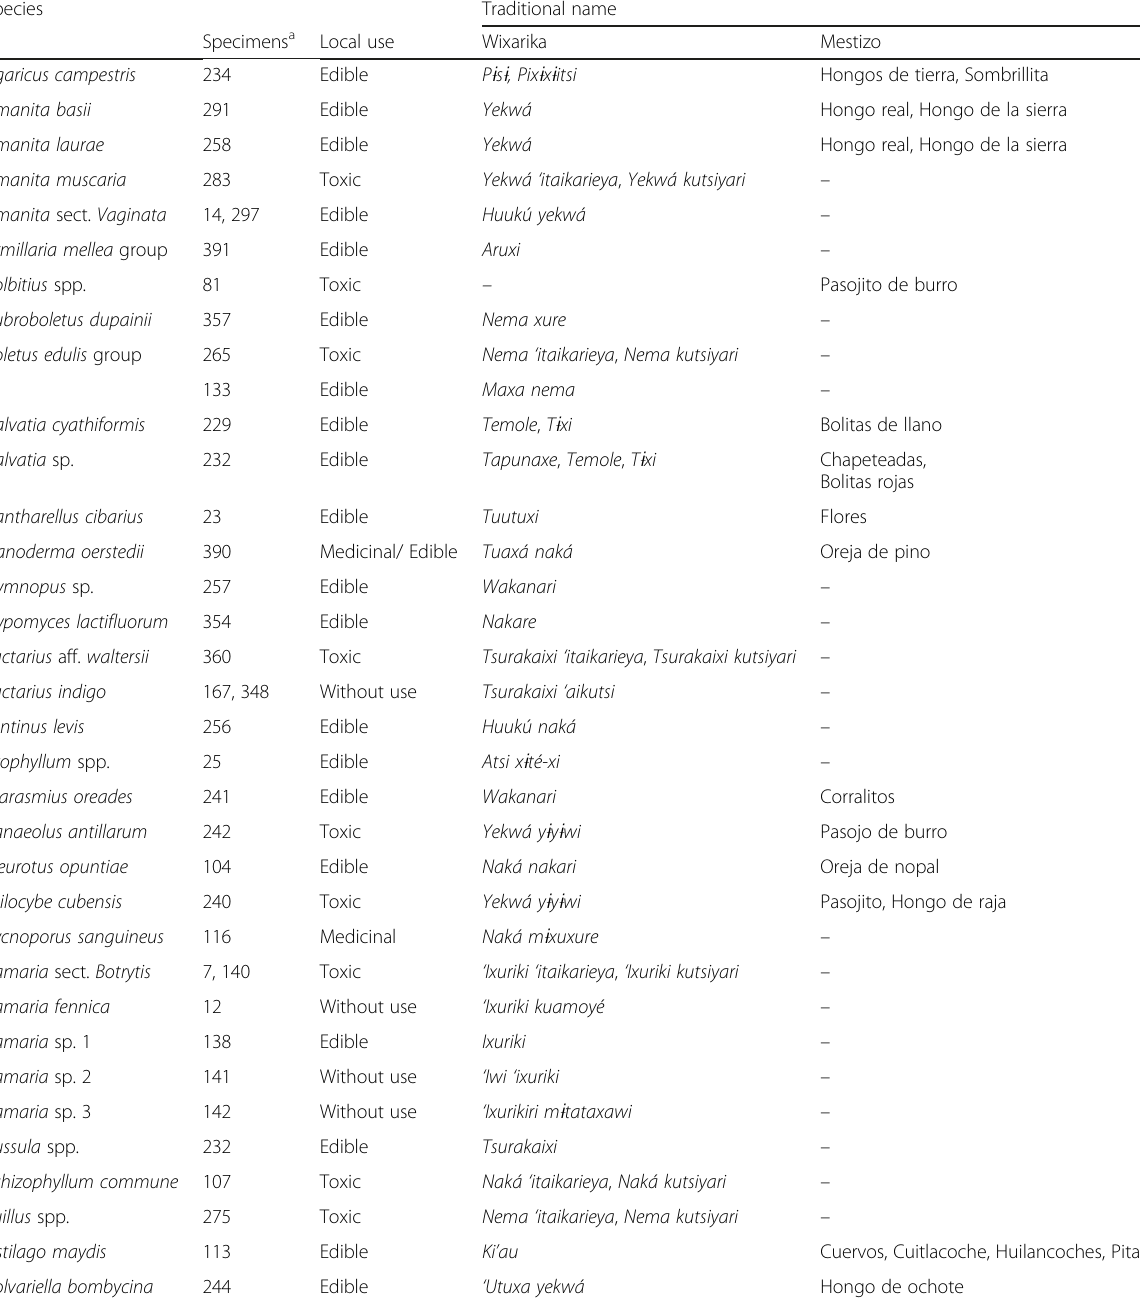
Table 1 Species of mushrooms, vouchers, uses, and traditional names recognized by the Wixaritari and